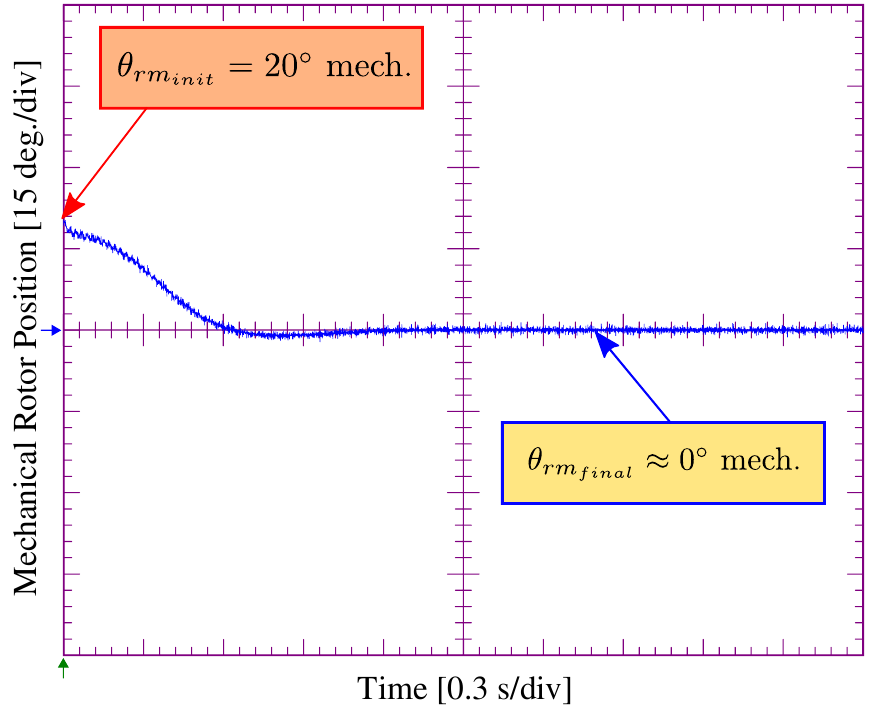
Figure 7. Mechanical rotor position of the proposed zero angle LFS injection based PMSM drive with FSTP inverter. Operating at: 0.25 pu d -axis voltage and zero q -axis voltage with 10 kHz switching frequency under fan type loading